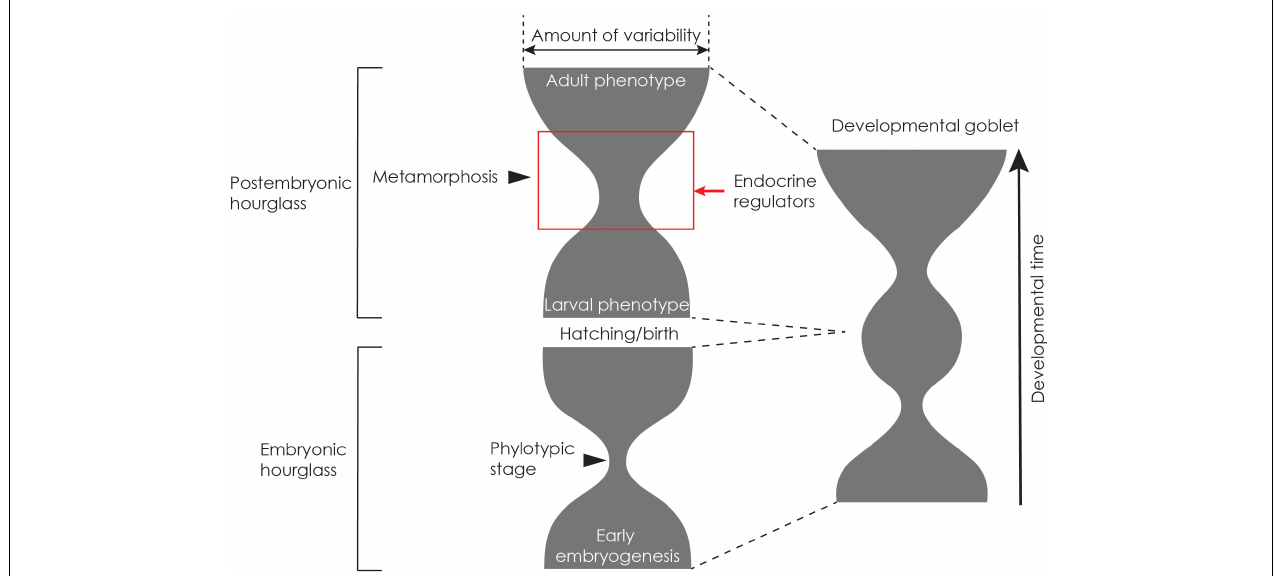
FIGURE 5 | The developmental goblet model for metamorphic organisms. The phenotypic diversity of metamorphic animals results from two stacked developmental hourglasses, the developmental goblet, which is composed of an embryonic hourglass and a postembryonic hourglass. The horizontal width of the hourglass represents phenotypic diversity across a taxon. The vertical axis represents developmental time with the top of the goblet representing the adult stage. Early larval ecologies are diverse and are reflected in the diversity of larval phenotypes. During metamorphosis, a small number of developmental hormones constrain development. Subsequently, developmental trajectories diverge to generate various adult